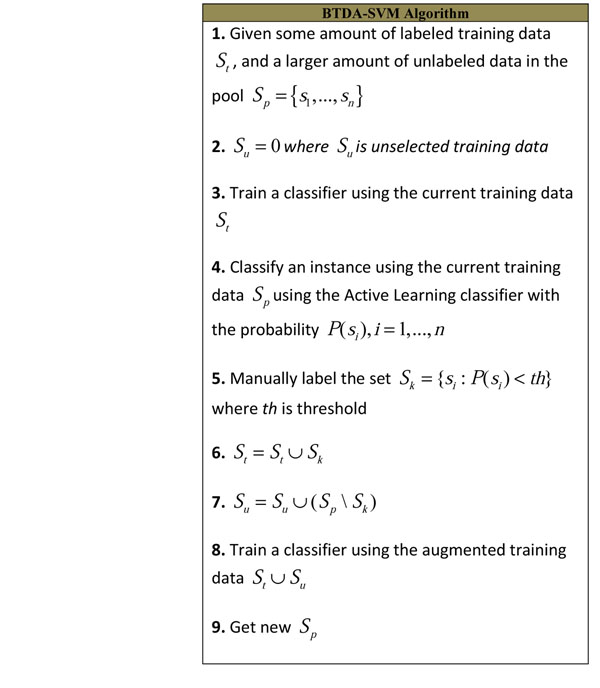
BTDA-SVM algorithm